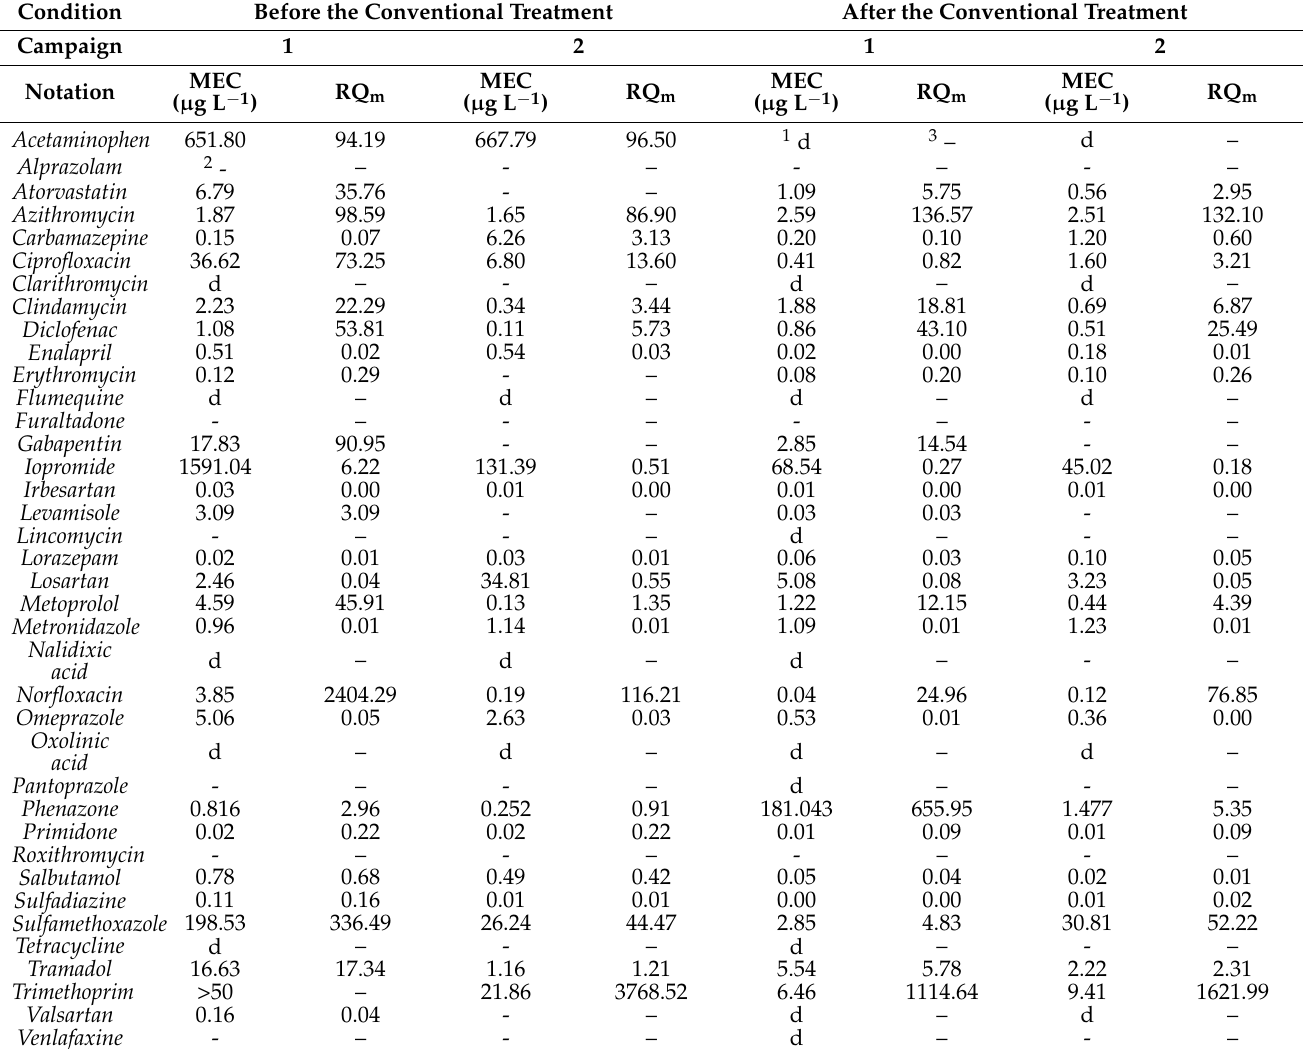
Table 5. Concentration of the target pharmaceuticals in the HWW from Manizales before and after the conventional treatment and their RQ m values under Scenario c